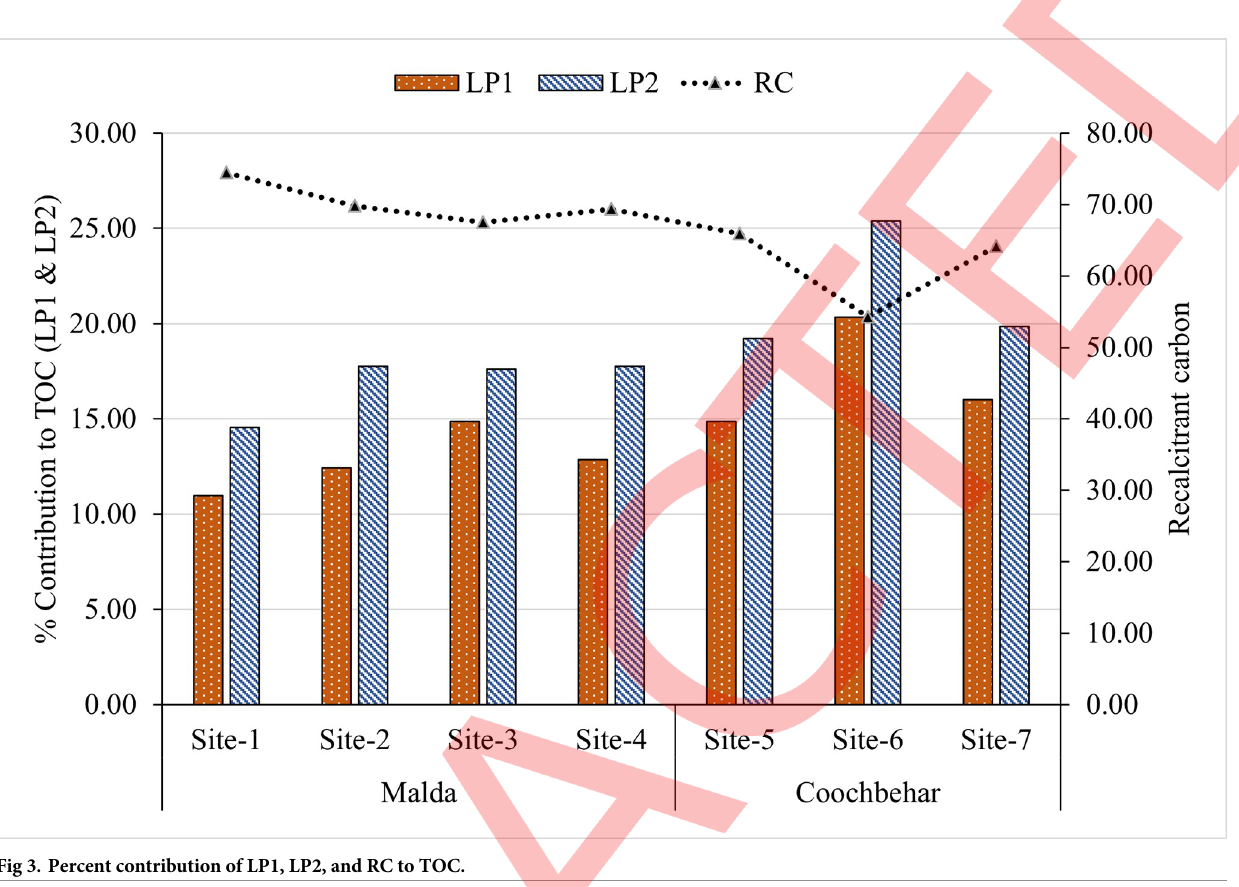
Fig 3. Percent contribution of LP1, LP2, and RC to